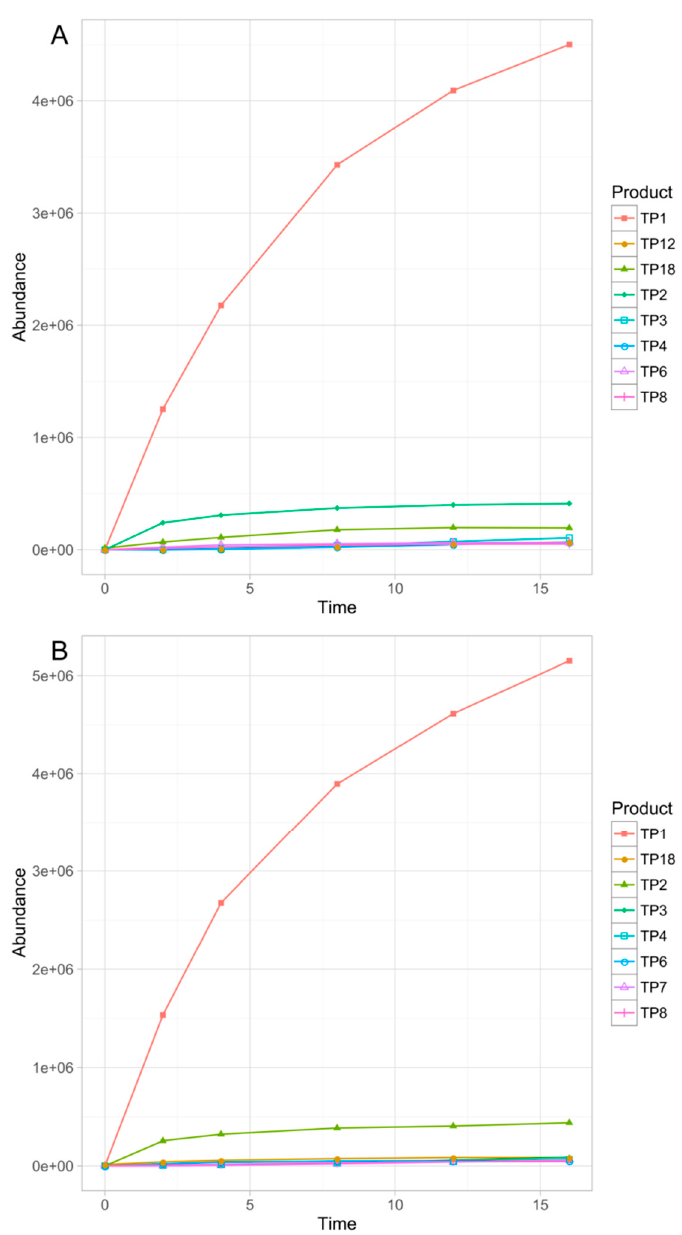
Figure 6. Evolution profiles of the TPs formed in Serdolect ® 4 mg ( A ) and Serdolect ® 16 mg ( B ) experiments.